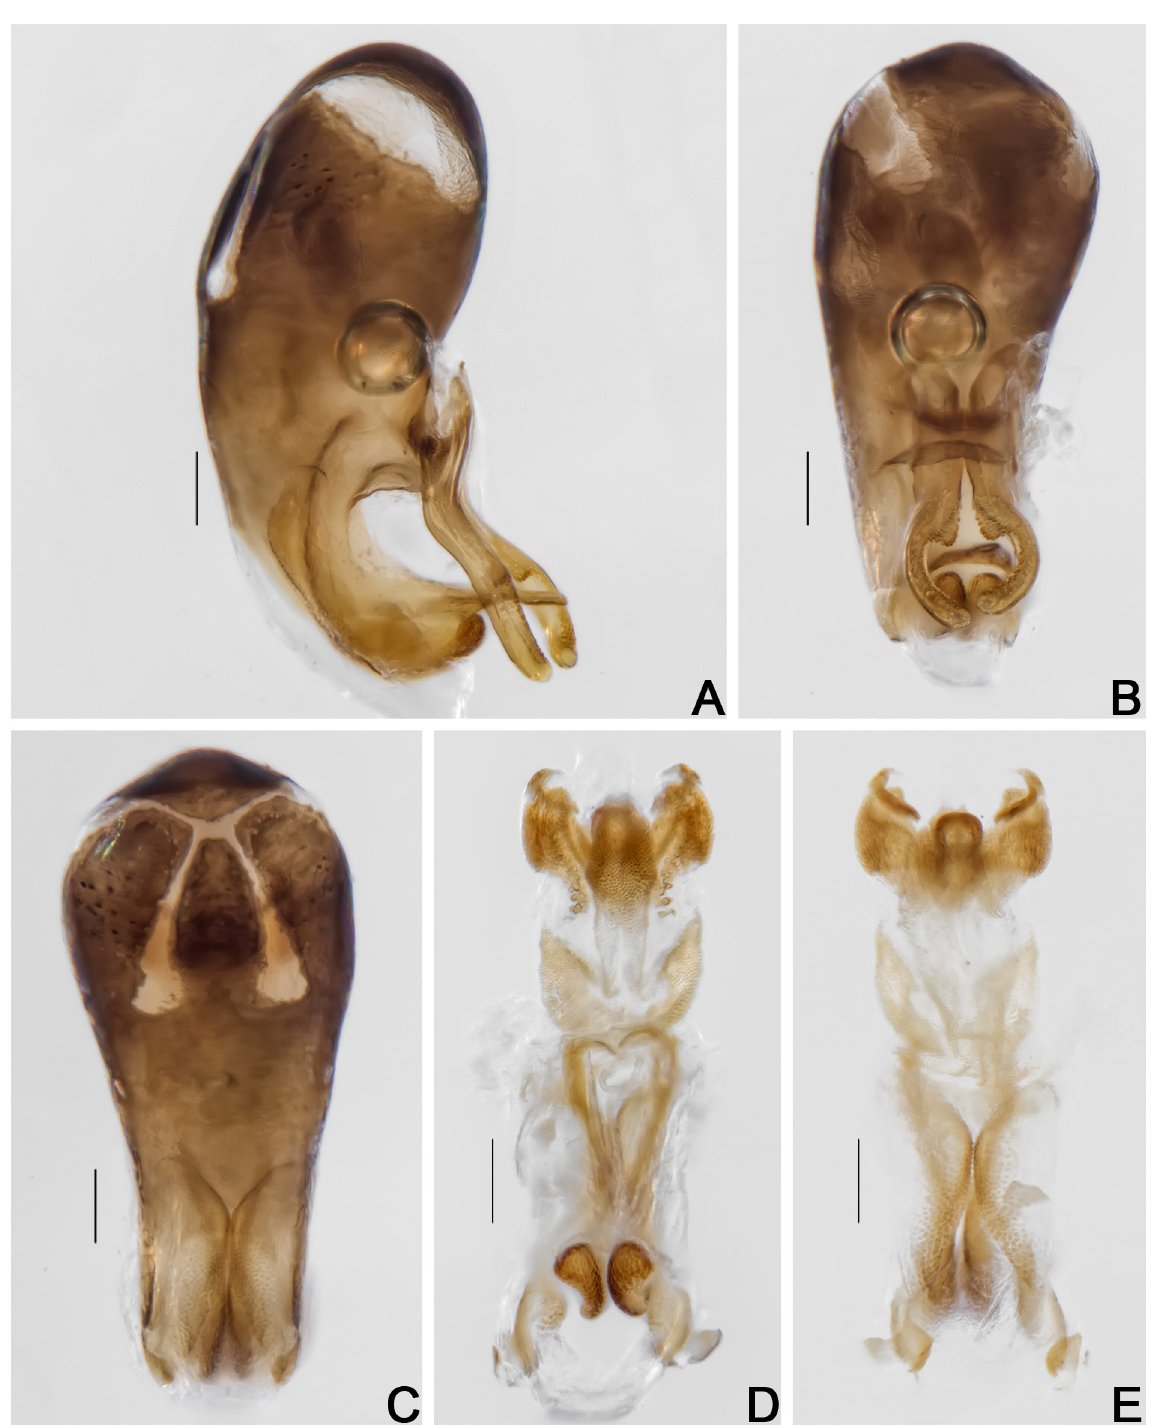
Fig. 53. Cyparium collare Pic, 1920, ♂ (CELC). A–C . Aedeagus. A . Lateral view. B . Frontal view. C . Dorsal view. D–E . Internal sac. D . Frontal view. E . Dorsal view. Specimen collected at Mata do Paraíso, Viçosa (MG, Brazil). Scale bars = 0.1